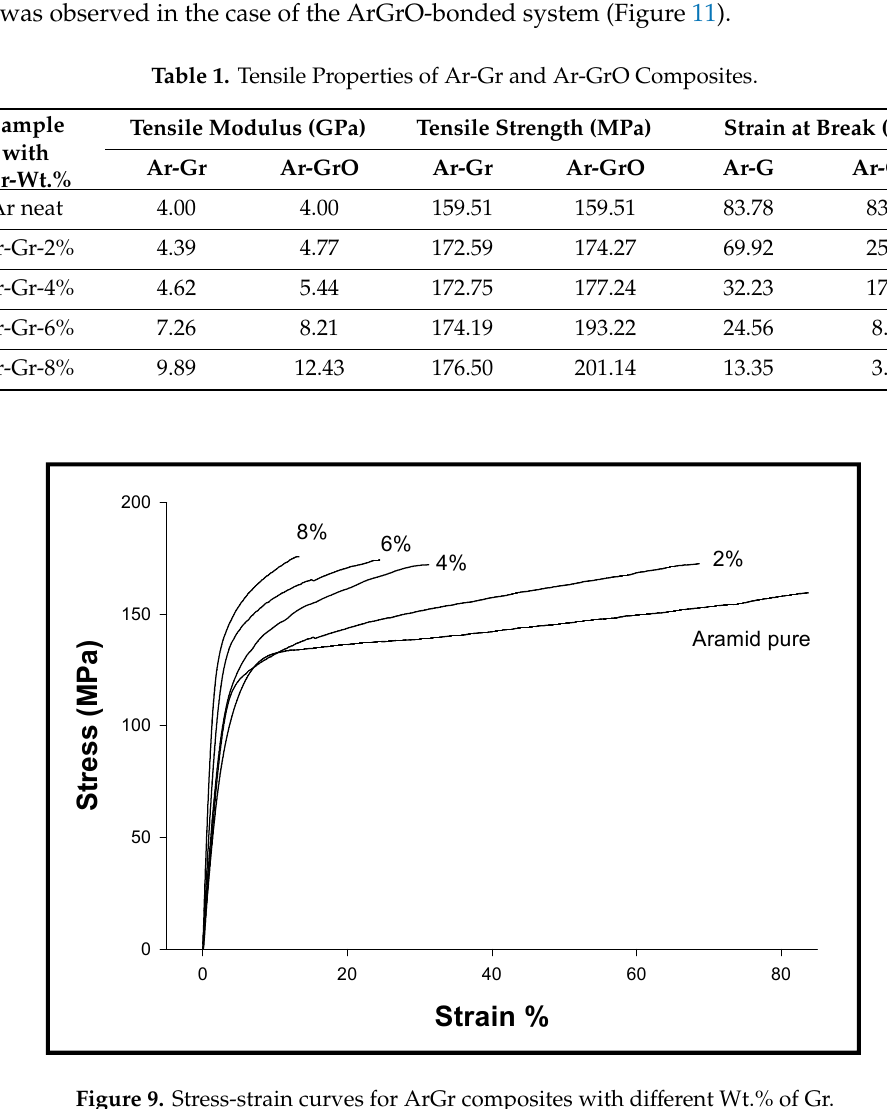
Table 1. Tensile Properties of Ar-Gr and Ar-GrO Composites.